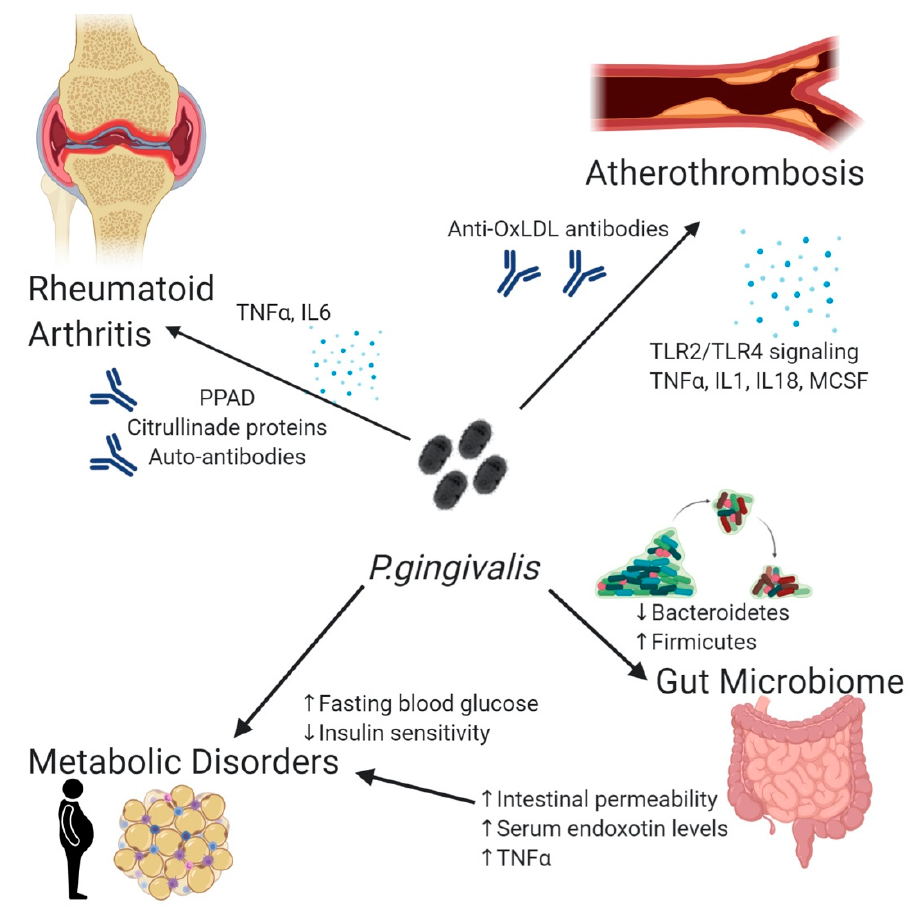
Figure 1. Porphyromonas gingivalis influences the development of multiple chronic inflammatory conditions. Through the cross-reactive antibodies (atherothrombosis, rheumatoid arthritis), increased levels of systemic inflammation (atherothrombosis, rheumatoid arthritis, gut microbiome dysbiosis, metabolic disorders), as well as overall microbiome dysbiosis. ( ↑ = increase ↓= decrease)